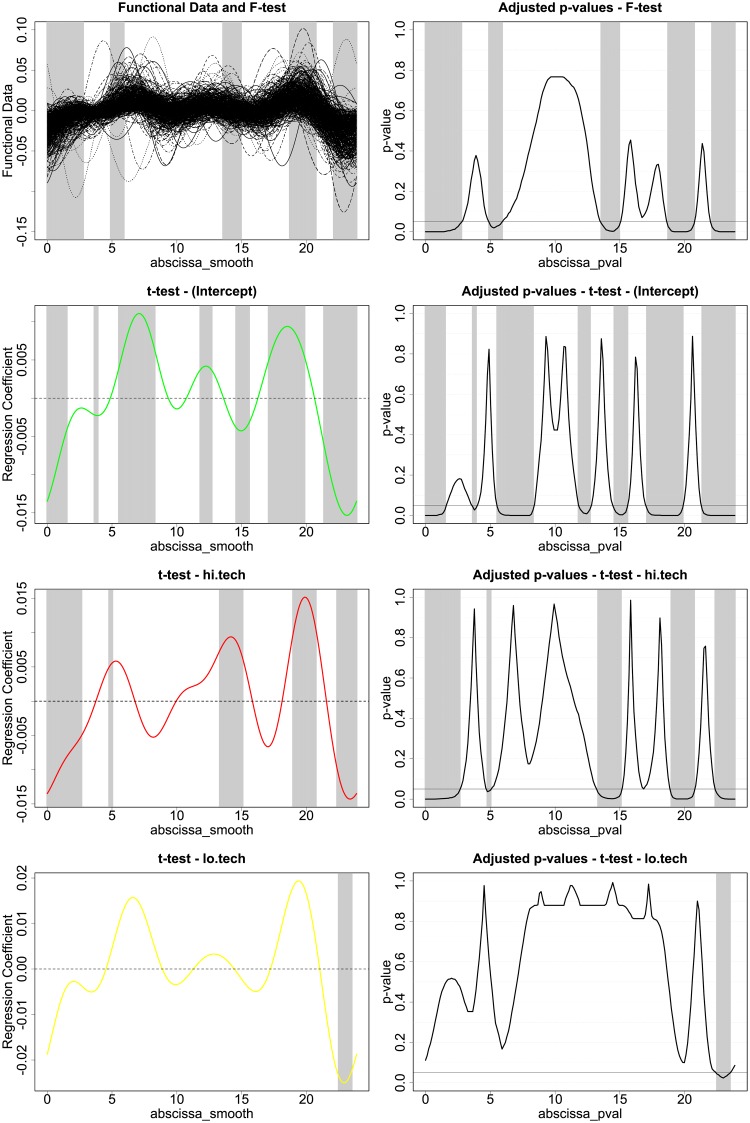
F-Test and t-Tests for regression model 4.